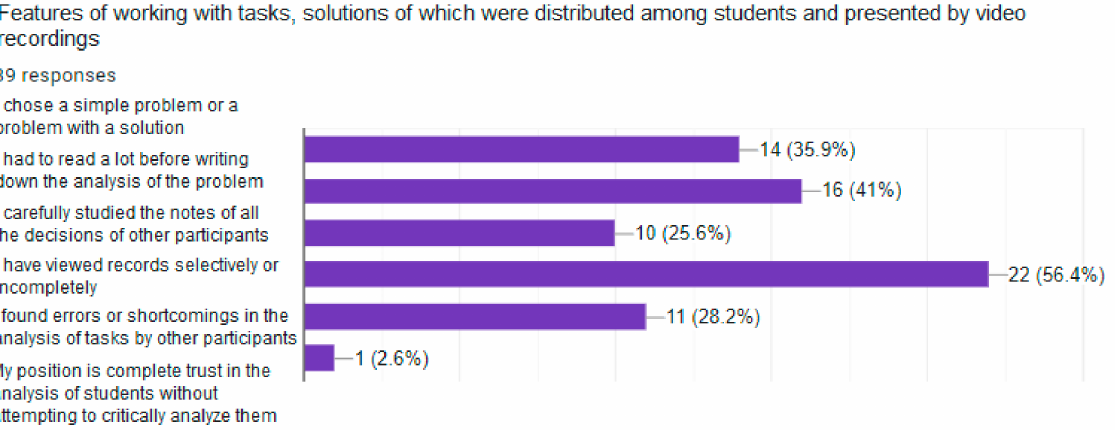
Figure 8. Distribution of student responses about working with videos of problem